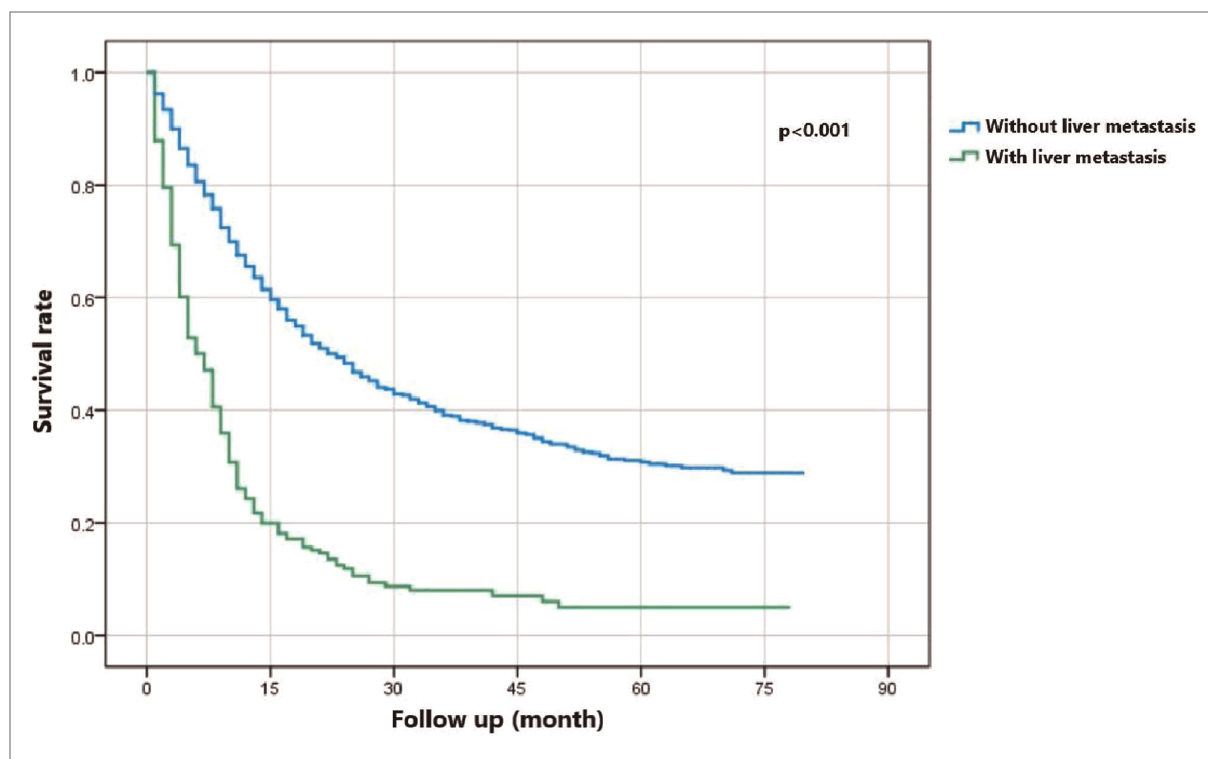
FIGURE 5 Survival curve of gallbladder cancer patients with and without liver